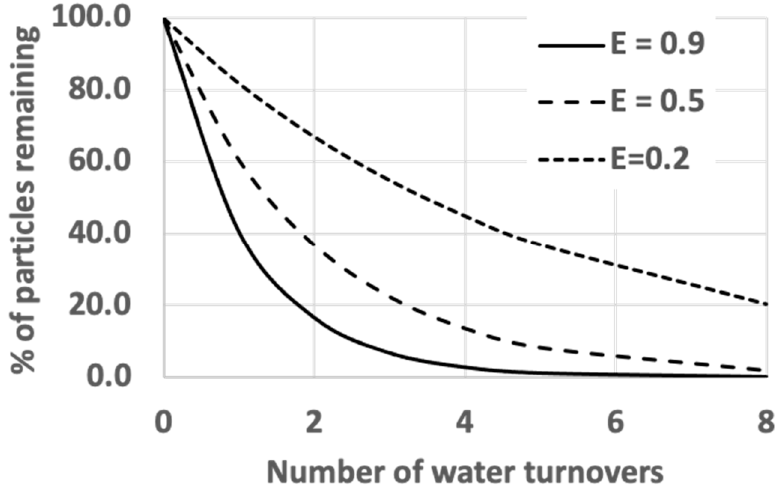
Figure 1. Effect of filter efficiency (E) on the removal of dirt particles from pool water (expressed as percentage of particles remaining) following successive water-turnover cycles, based on the Gage–Bidwell Law of Dilution.